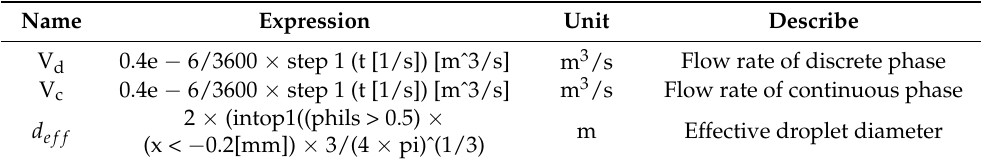
Table 2. Definition of condition variables.